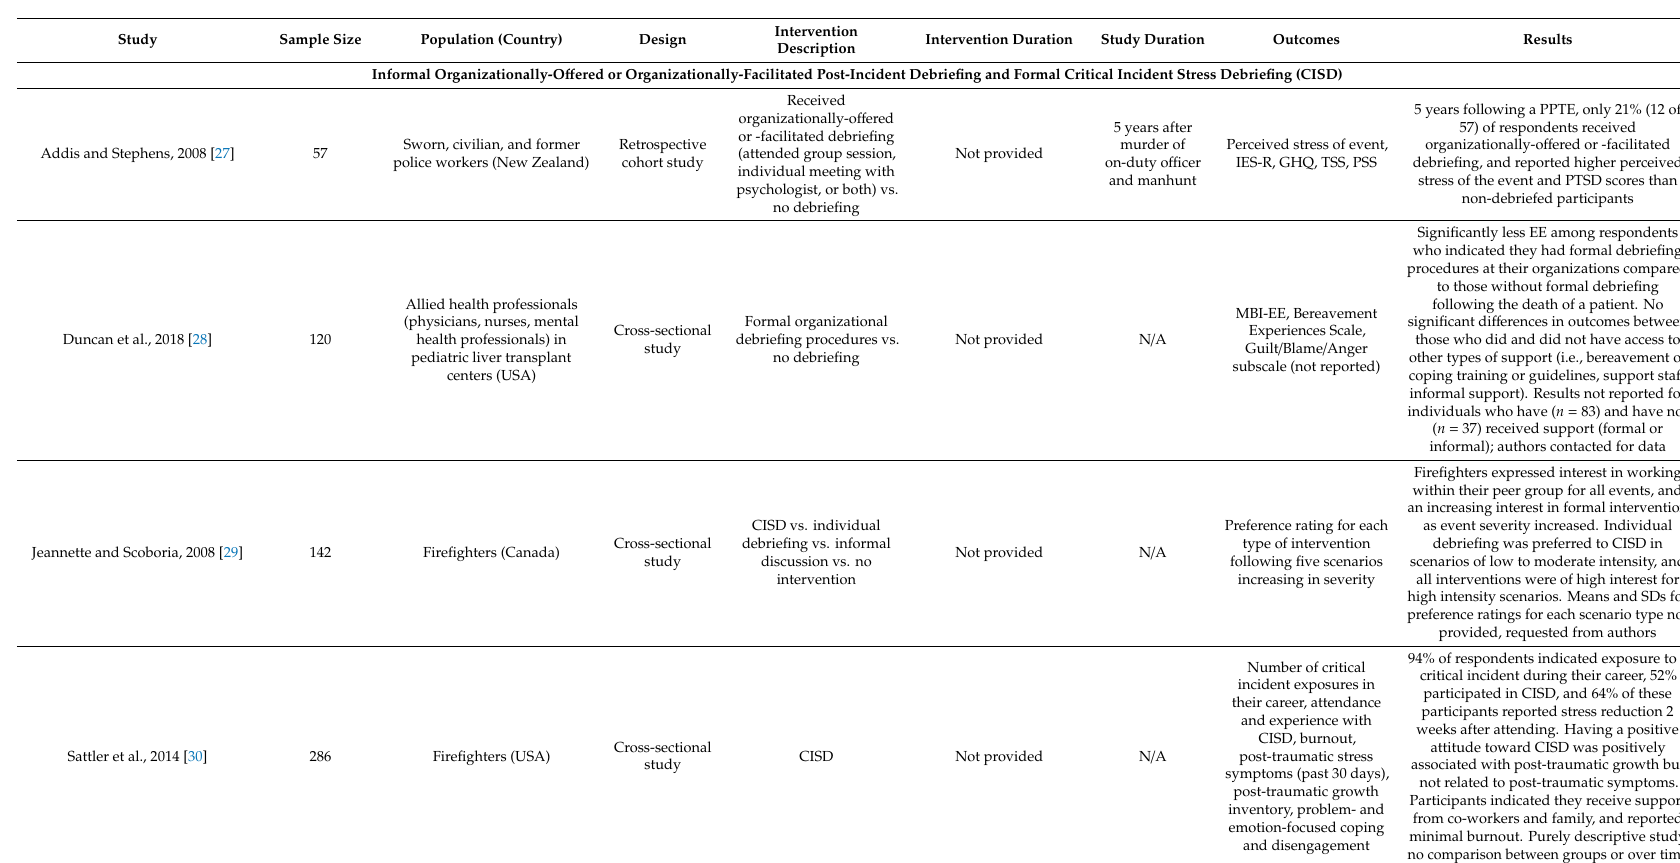
Table 2. Eligible studies investigating organizational services for public safety, frontline healthcare, and public transport professionals following potentially psychologically traumatic